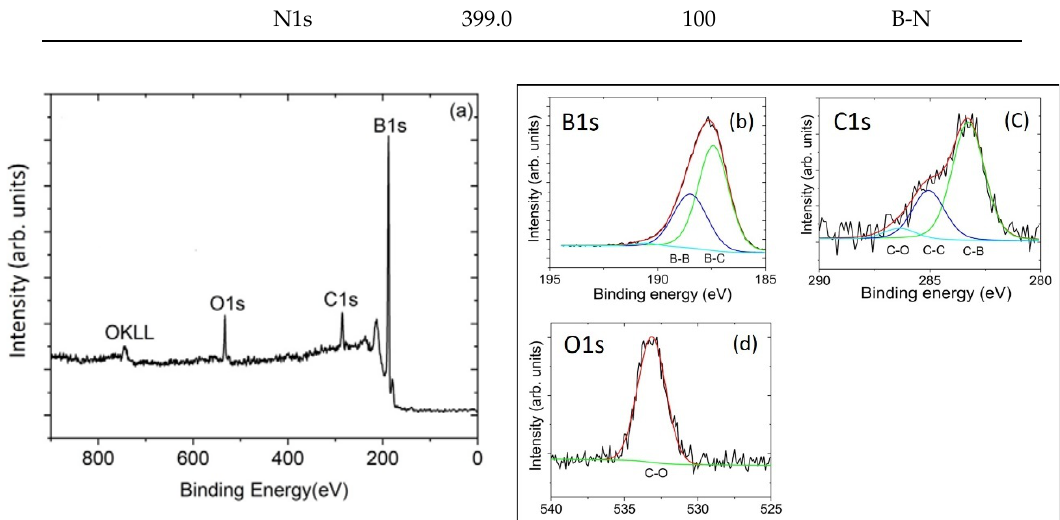
Figure 2. X-ray photoelectron spectroscopy survey scans of ( a ) the BC-1 coating with an elemental composition of 88.1% B, 8.7% C, and 3.2% O. Panels ( b – d ) show high-resolution scans for B1s, C1s, and O1s, respectively, with corresponding peaks assigned to B-C, B-B, and C-C (adventitious carbon) bonding. Sample BC-1 also shows bonding associated with C-O.